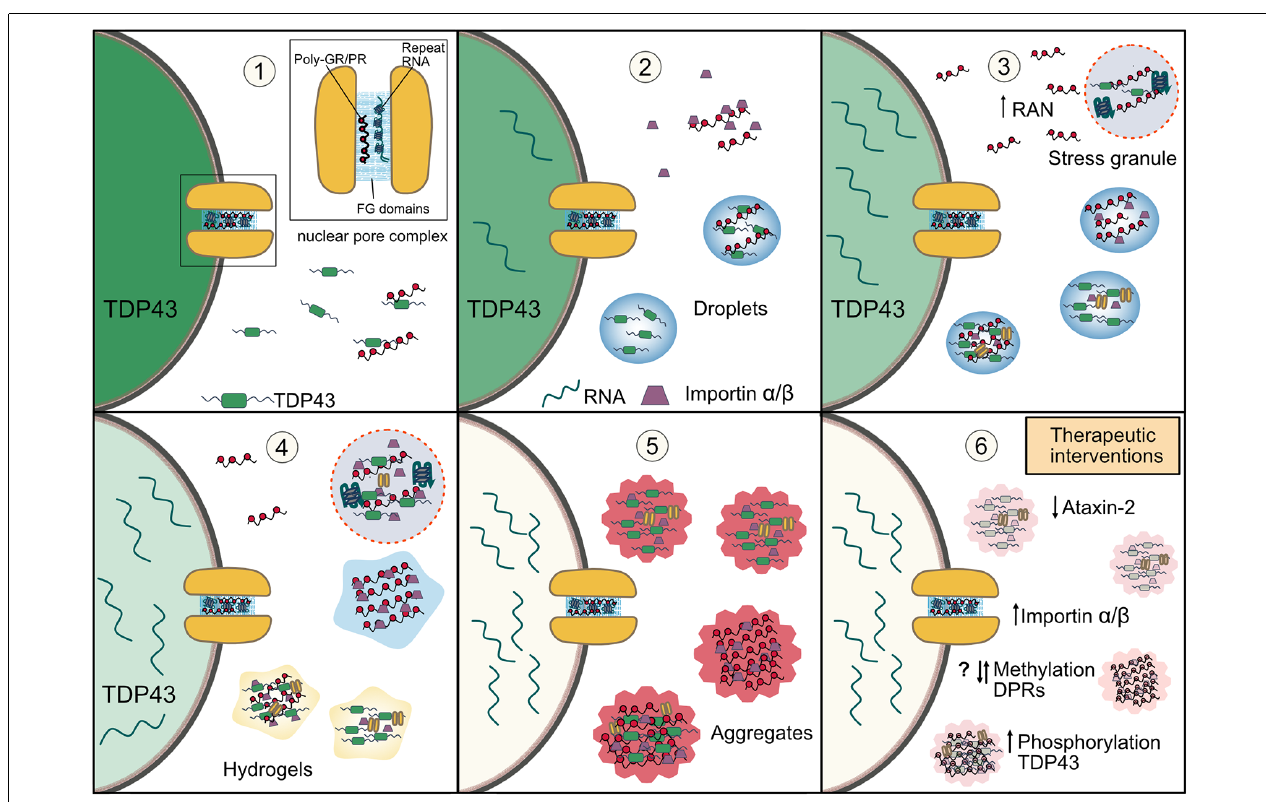
FIGURE 3 | How disruptions in phase separation and membraneless organelles may lead to TDP-43 aggregation in C9orf72 -ALS/FTD and possible therapeutic strategies. (1) C9orf72 arginine rich DPRs and G 4 C 2 repeat RNA bind nuclear pore proteins with phenylalanine rich repeats (FG domains) and result in nucleocytoplasmic transport dysfunction and mislocalization of TDP-43 to the cytoplasm. (2) Interaction between cytoplasmic TDP-43 and the arginine rich DPRs results in the LLPS of TDP-43 in the cytoplasm. Impaired nucleocytoplasmic transport also results in an accumulation of the importin- α / β complex (the import receptor for TDP-43) in the cytoplasm where it is also bound by the arginine rich DPRs and results in their reduced solubility. This begins a vicious feedback loop as impaired nuclear import of TDP-43 further increases levels of cytoplasmic TDP-43, whose LLPS is potentiated by a nuclear retention of mRNA from impaired nuclear export. (3) Cellular stress and the direct interaction of arginine rich DPRs and G 4 C 2 RNA with stress granule proteins (including TDP-43) promotes phase separation and the formation of stress granules. The arginine rich DPRs also induce condensation of importin- α / β . TDP-43 droplets recruit importin- α / β complexes and nuclear pore proteins further impairing nucleocytoplasmic transport, resulting in more TDP-43 accumulation in the cytoplasm and depletion of nuclear TDP-43. Both stress granule accumulation and cytoplasmic TDP-43 also enhance RAN translation of the arginine rich DPRs. (4) The stress granules induced by the arginine rich DPRs and repeat RNA have reduced dynamics which entraps TDP-43, import receptors and nuclear pore proteins. Persistent TDP-43 and DPR-importin- α / β droplets are likely to mature into more solid-like states such as hydrogels, further immobilizing these proteins. (5) TDP-43 in solid-like states and within stress granules, and also DPRs, mature into pathological insoluble aggregates which further sequester proteins involved in nucleocytoplasmic transport. Thus, the disruption of phase separation and membraneless organelles leads to a cascade of vicious feedback loops which result in depletion of nuclear TDP-43 and its accumulation and aggregation in the cytoplasm in disease. (6) Therapeutic targeting of stress granules by reducing ataxin-2 levels, manipulating post-translation modifications such as methylation of the DPRs and phosphorylation of TDP-43, or increasing importin- α / β to reduce excessive LLPS may enhance the solubility of TDP-43, help to reduce its aggregation and ameliorate the pathological cascade in C9orf72 -ALS/FTD and other TDP-43 proteinopathies.